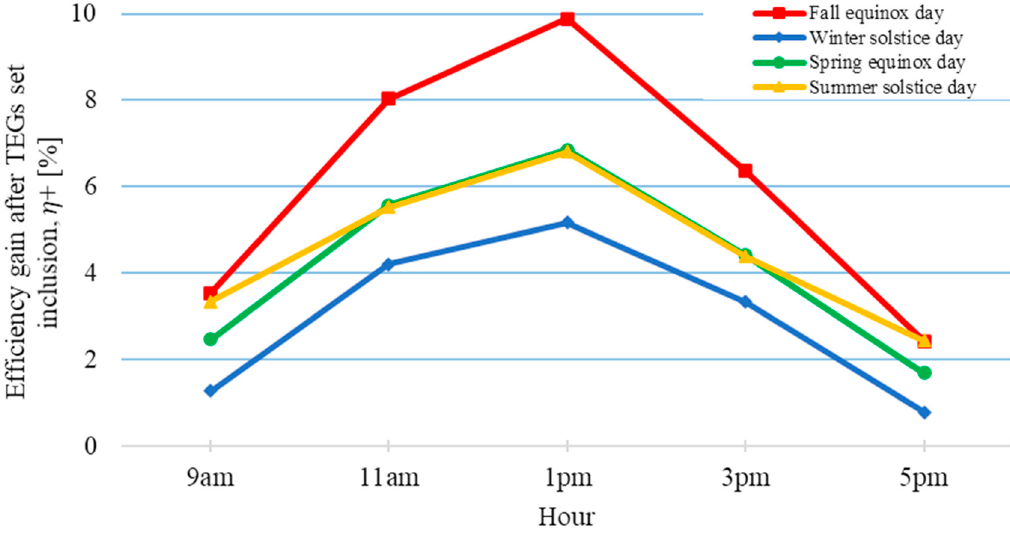
Figure 17. Percent efficiency gain after TEGs set inclusion.